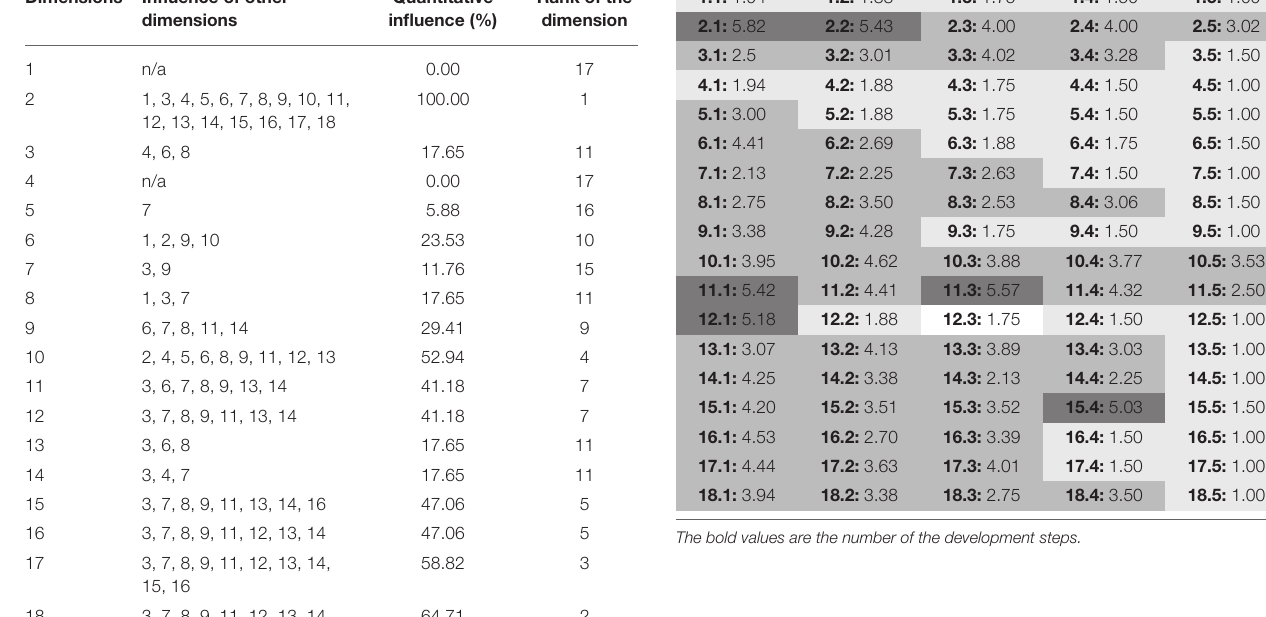
TABLE 2 | The dimensions and their qualitative Quantitative Rank of the influence (%) dimension